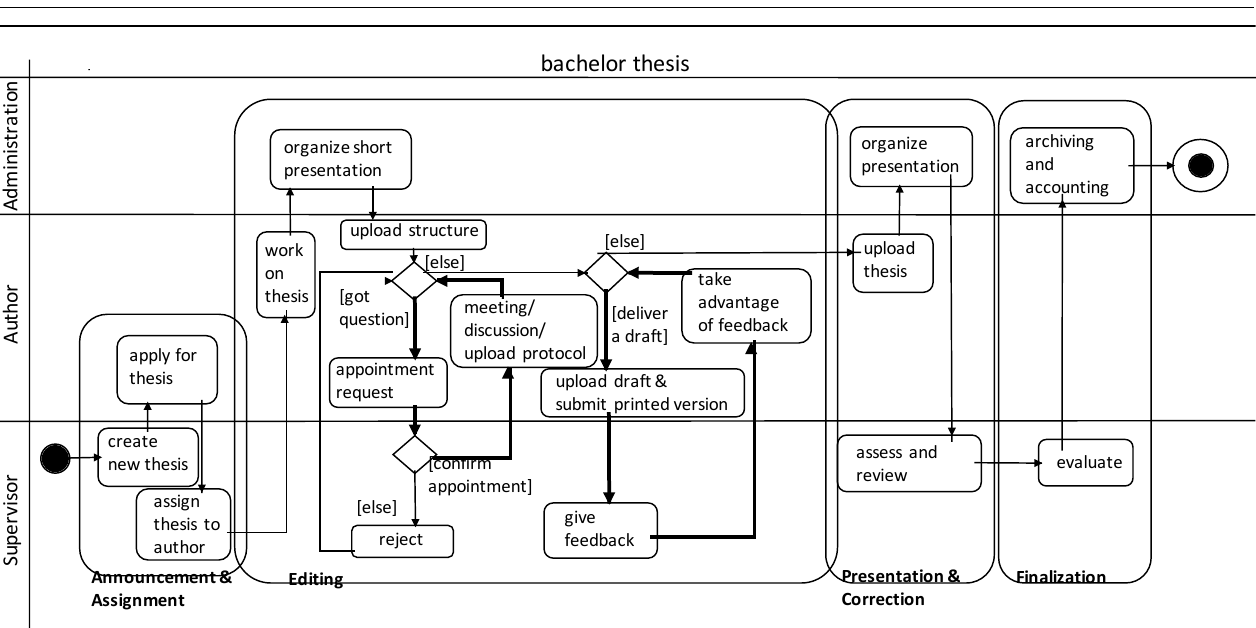
Figure 1. UML activity diagram for a bachelor thesis. The four major activities are described in the text. Feedback loops in bold.